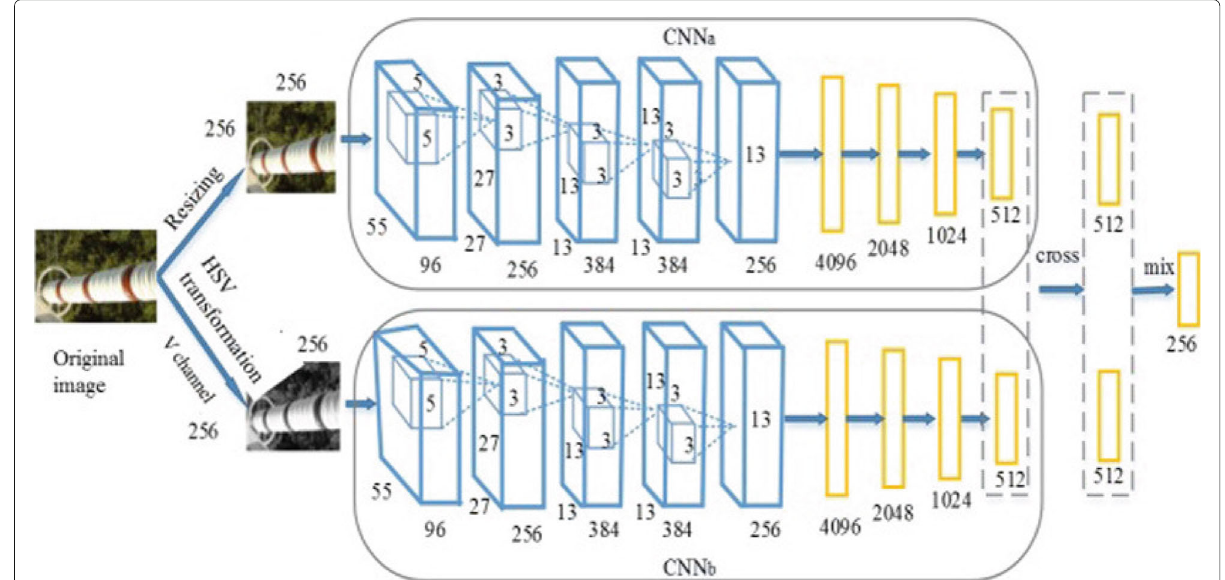
DC-CNN carries out two cross-mixings on two sets of characteristics. First, the outputs of the two full connec- tion layers are cross-connected and used as the input of the next full connection layer. Then, the next full connec- tion layer is split into two parts, the data in these two parts are mixed and connected, and the obtained feature vectors are the final features of the images. The designed DC-CNN model of the 11-layer deep convolutional neural network (DCNN) is shown in Fig. 2.